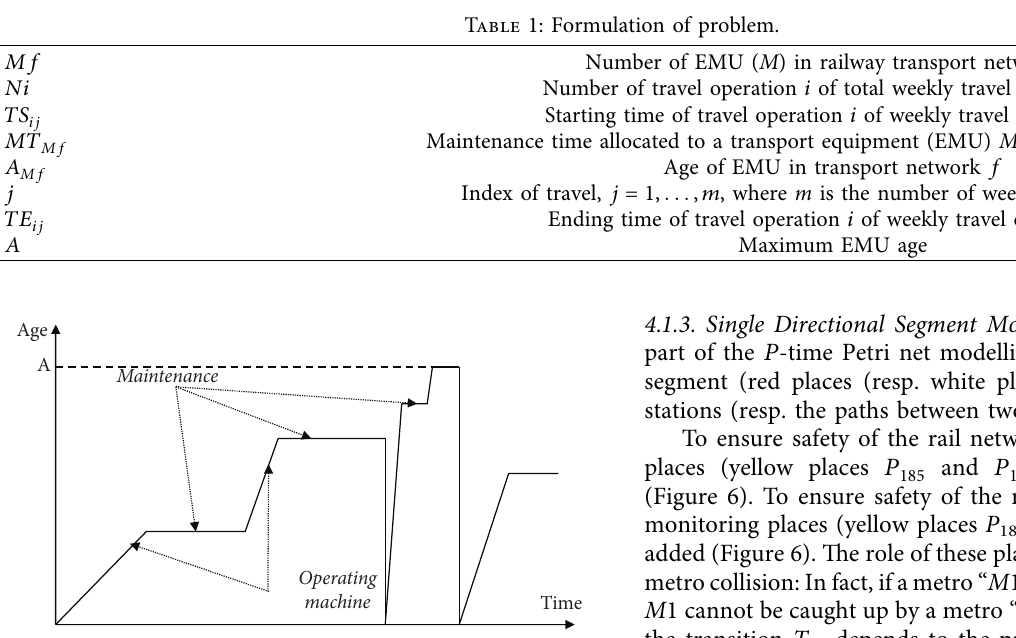
Figure 2: Modelling of the maximum EMU age A